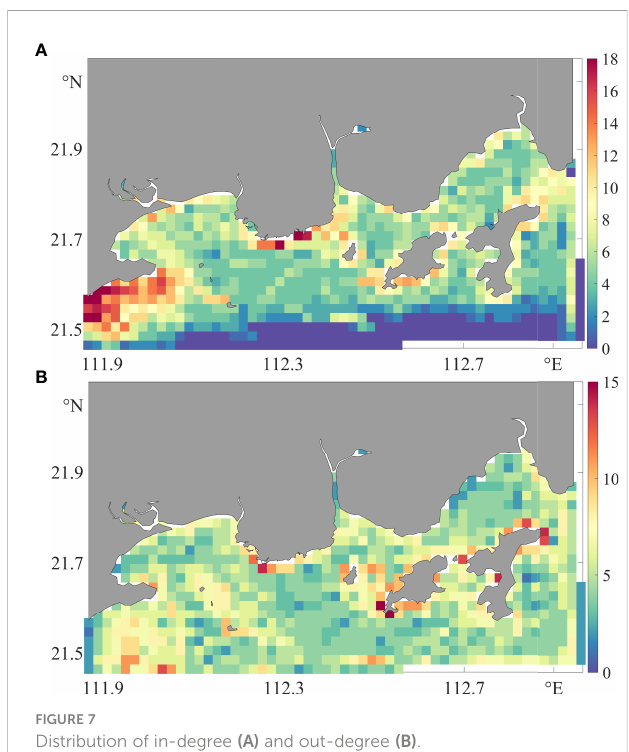
FIGURE 7 Distribution of in-degree (A) and out-degree (B)